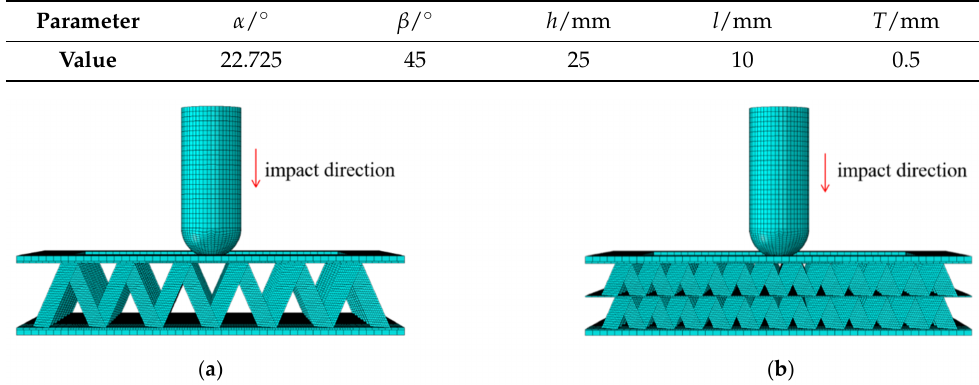
Figure 4. Geometry of unit cell of a single − layer V − shaped foldcore. Table 4. Parameters of single-layer V-folded unit cells.